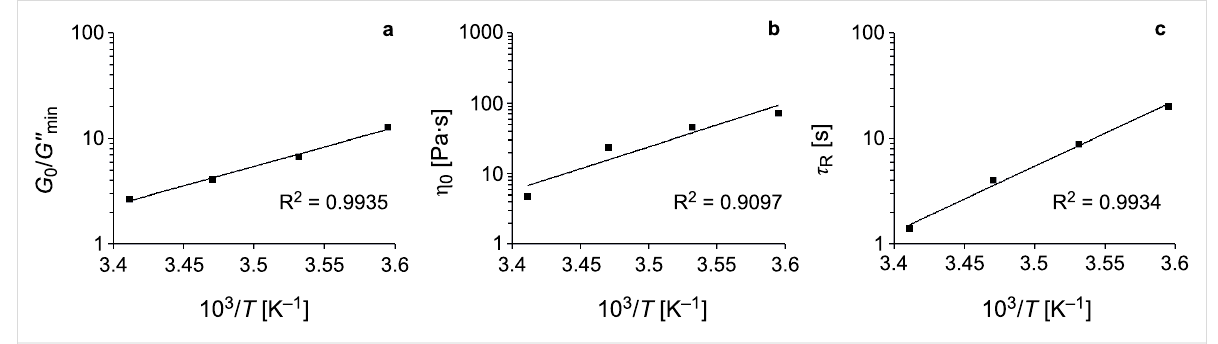
Figure 7: Semilogarithmic plot of (a) G 0 / G'' min , (b) η 0 , and (c) τ R against the inverse absolute temperature for the 2 /toluene system (0.5 wt %). The solid lines are fits to an Arrhenius-like behavior.